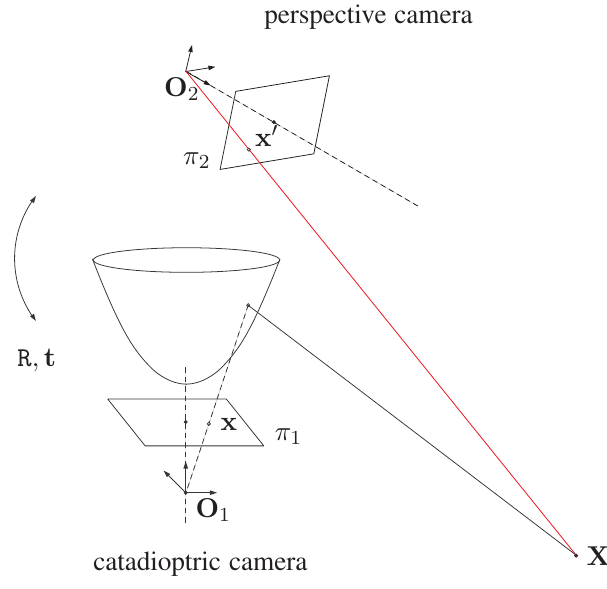
Figure 1. The proposed hybrid omnidirectional and perspective imaging system (HOPIS). It consists of a conventional camera and a catadioptric camera with a hyperboloidal